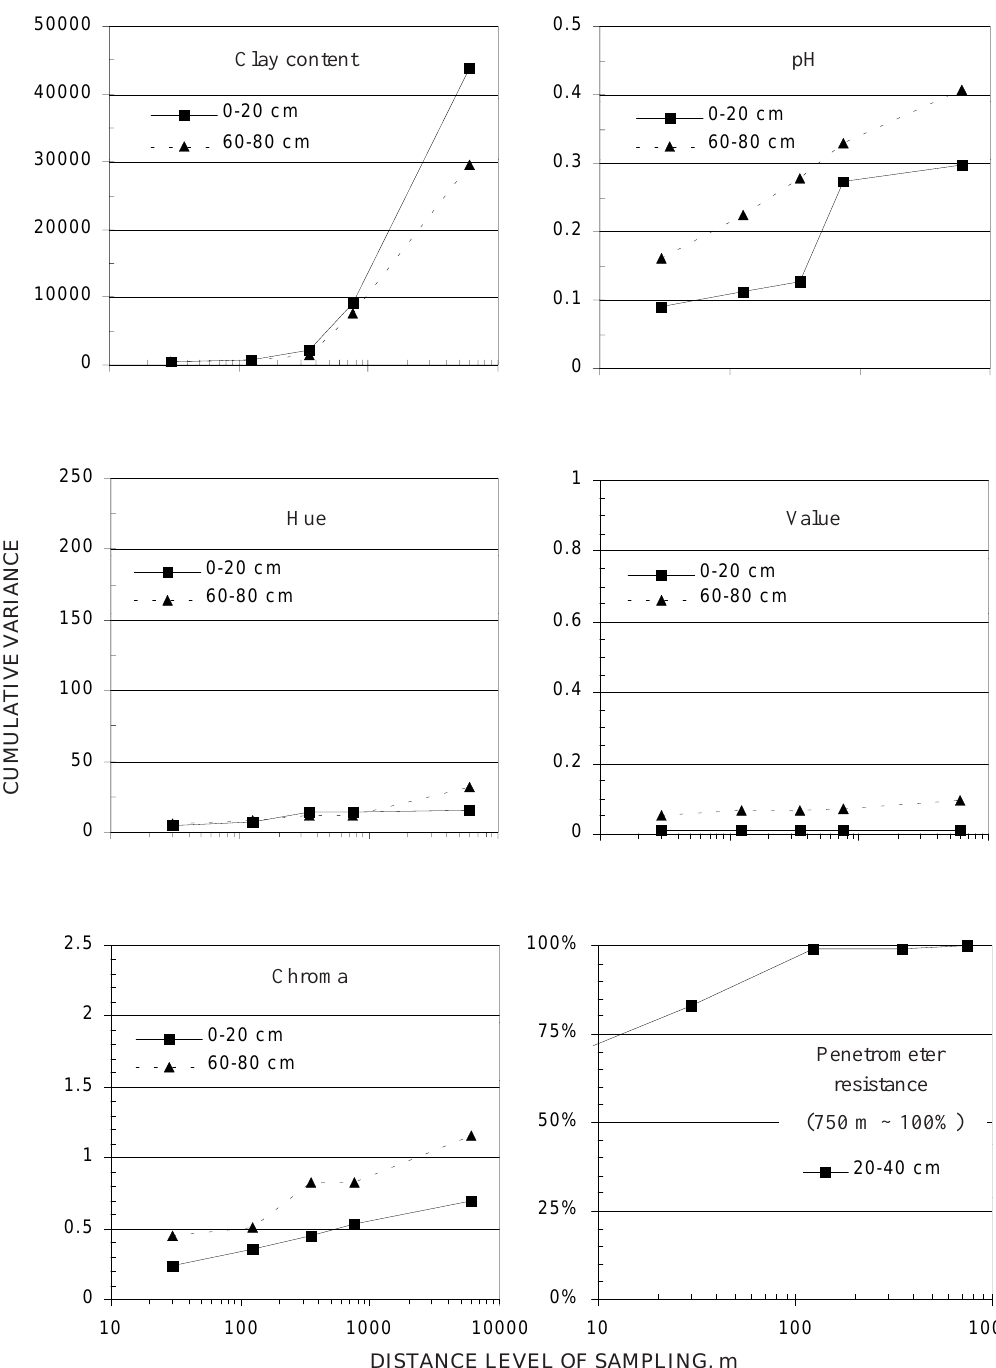
Figure 4. Nested variograms for the Assis